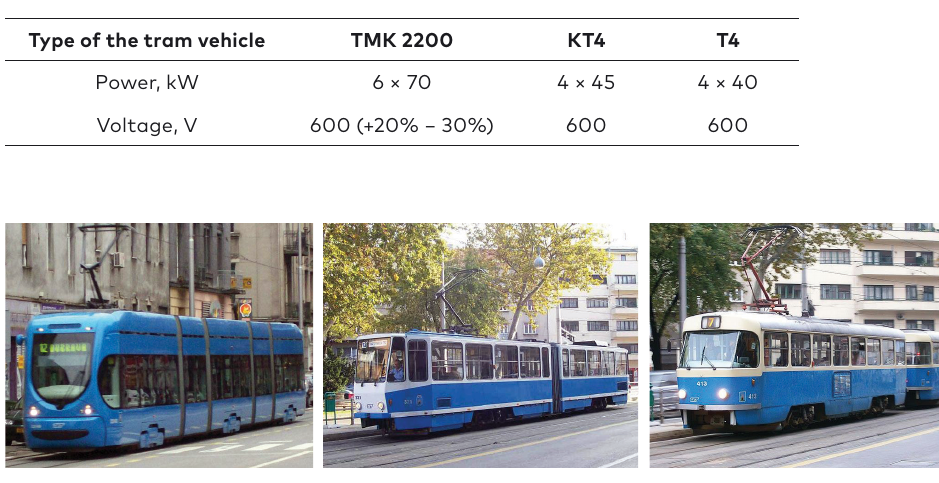
Table 1. Characteristics of tram